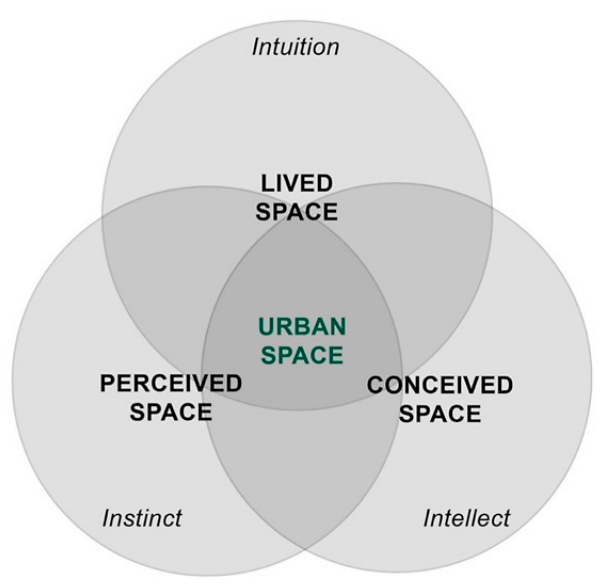
Figure 4. Lefebvre’s key interpretation of the formation of spaces [11,66]. Salama argued that Lefebvre’s framework facilitates understanding and